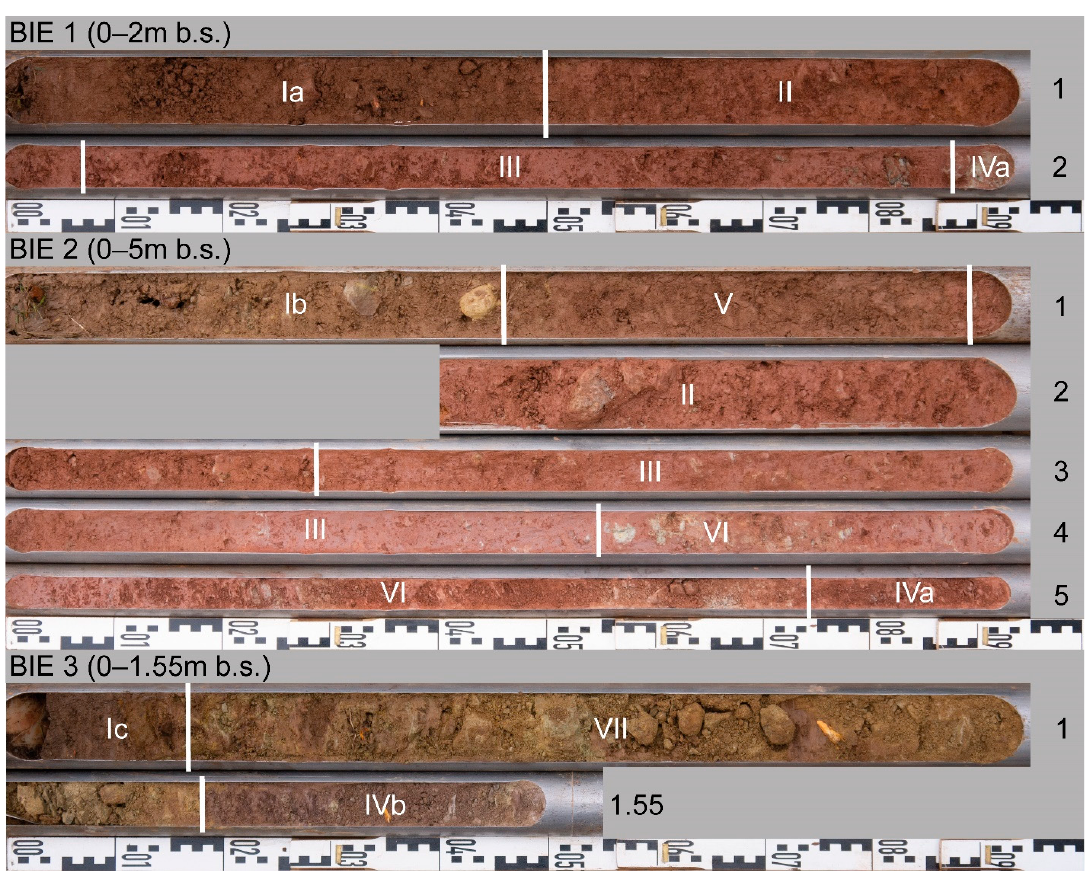
Figure 6. Photo of sediment cores BIE 1 ( upper ), BIE 2 ( middle ) and BIE 3 ( lower ). Ground surface upper left, coring base lower right of each core. Sediment units are described in Table 3.